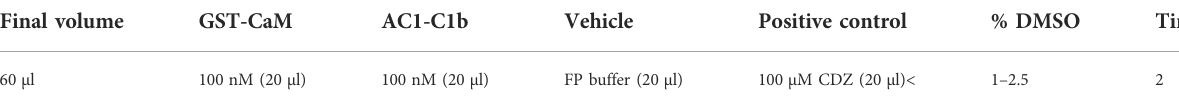
TABLE1AC1/CaMFPassayconditionsforthepilotscreen.ThetableindicatestheconcentrationsforallAC1/CaMFPassaycomponents.Theorderof addition for the AC1/CaM FP assay was vehicle, compound, or the positive control (CDZ) followed by GST-CaM and AC1-C1b after a 30-min incubation at RT.